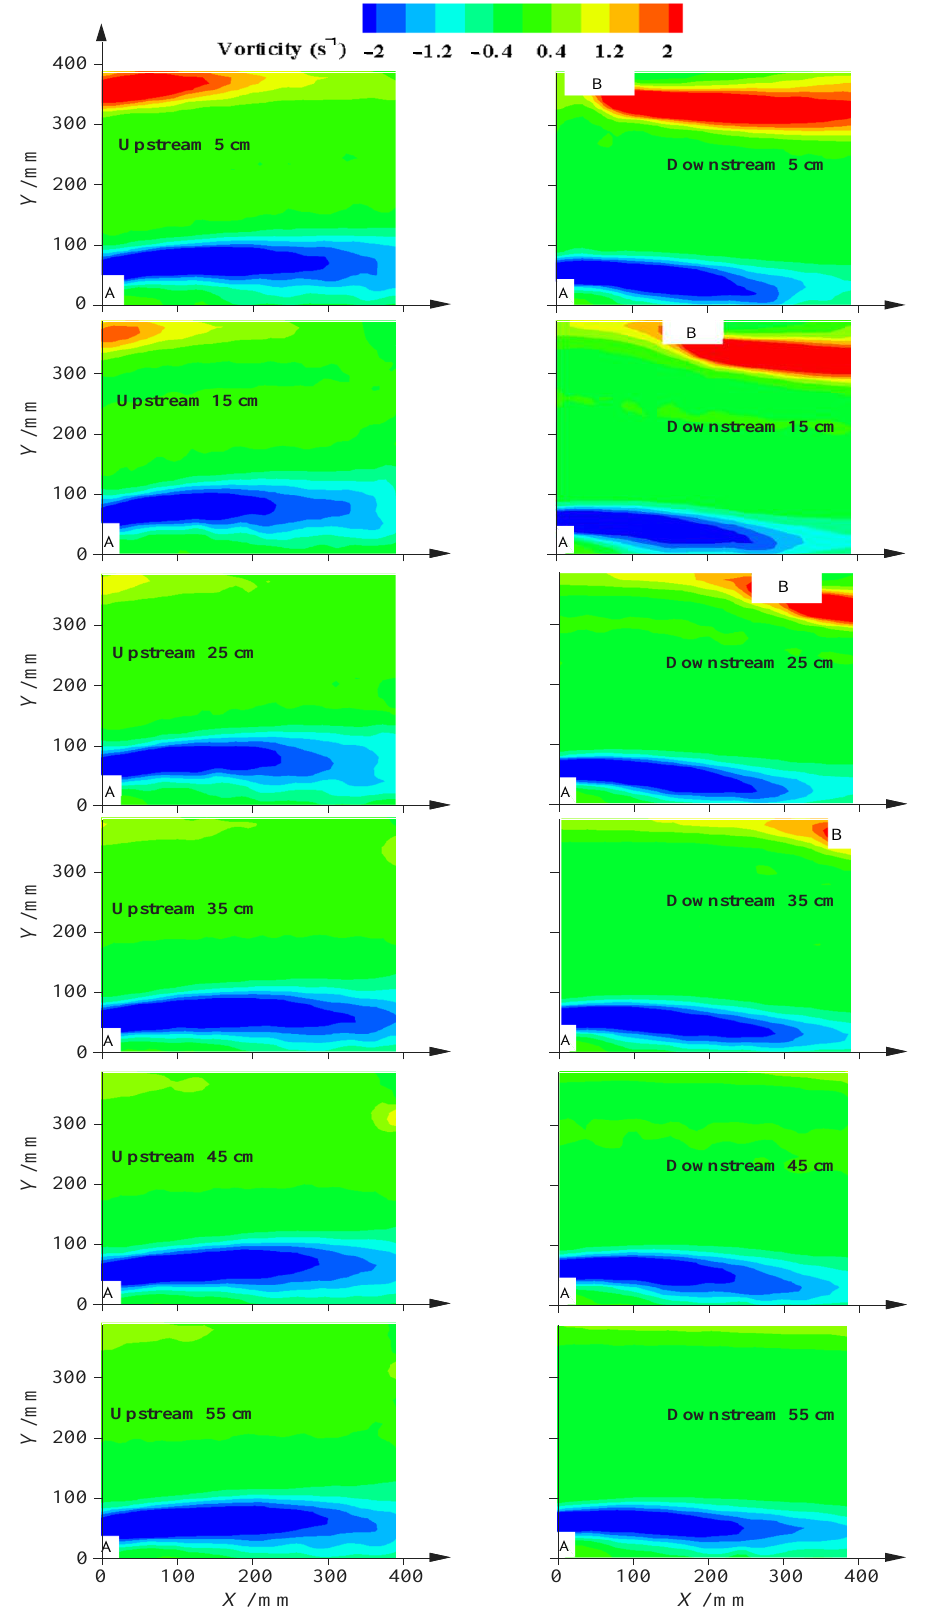
Figure 14. Vertical vorticity in the horizontal planes for alternating groin configuration with Groin B at 5 to 55 cm upstream (left column) and downstream (right column) from Groin A.